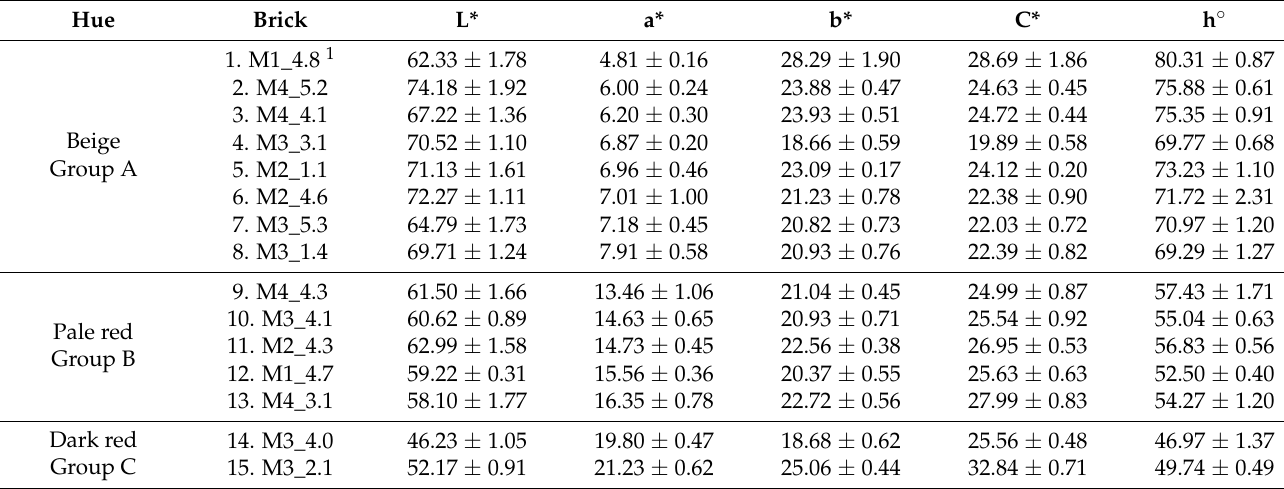
Table 1. Average and Std of lightness (L*), chromatic coordinates (a* and b*), chroma (C*) and hue angle (h°) of the ceramic bodies.